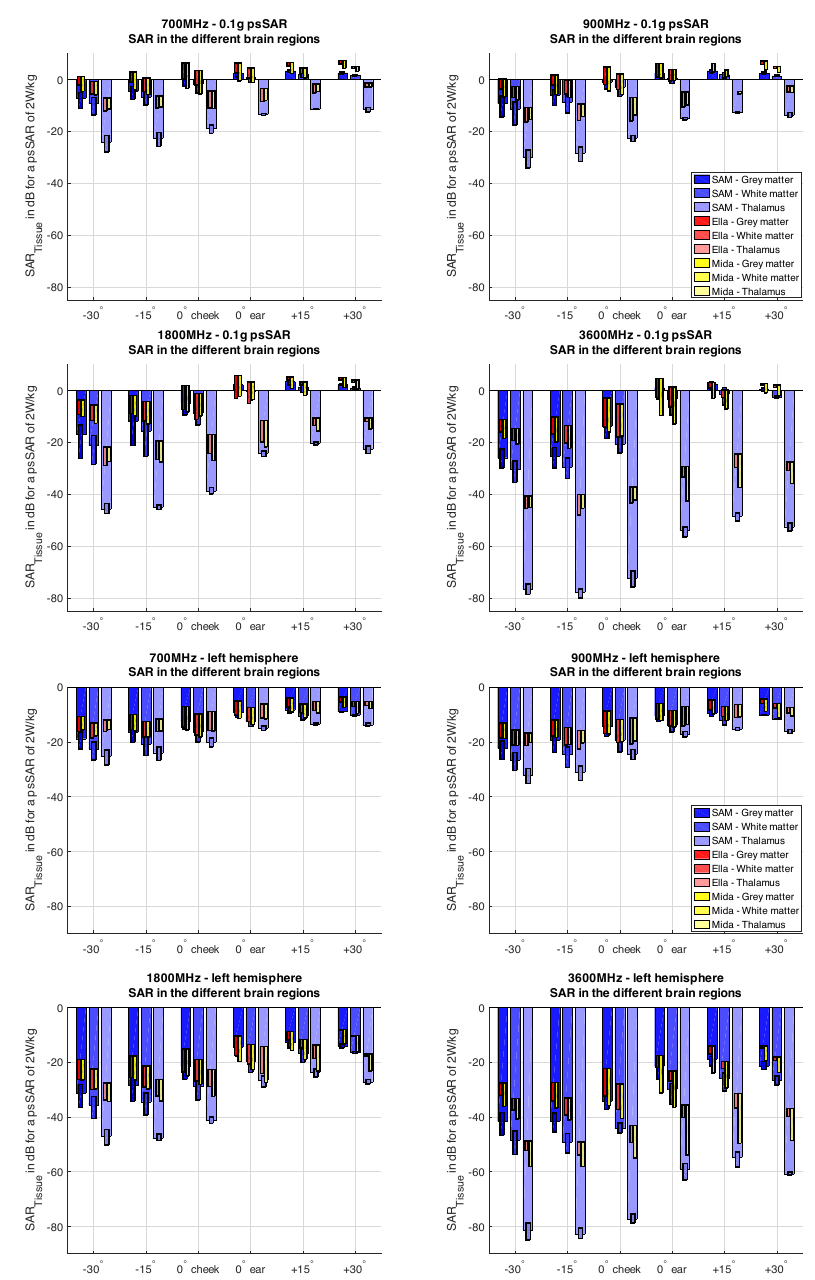
Figure 2. Characteristics of peak per tissue (top) and tissue-averaged (bottom) absorption for generic head-mounted sources simulating mobile phones as a function of frequency (700–3600 MHz) in three brain regions (white matter, grey matter, and thalamus) of human head phantom—the SAM phantom designated by standardization bodies for specific absorption rate (SAR) testing [29], the anatomical MIDA phantom [27], and the Ella phantom [28]—exposed to generic sources head-mounted sources, simulating mobile phone exposure in talk mode. In each plot, the SAR is normalized to the psaSAR 10g of each exposure configuration. According to IEEE C95.1, the SAR in the pinna of Ella is excluded from the averaging volume. The plots show the average and variability over all source positions for SAM in blue, the variability for Ella in red, and for MIDA in